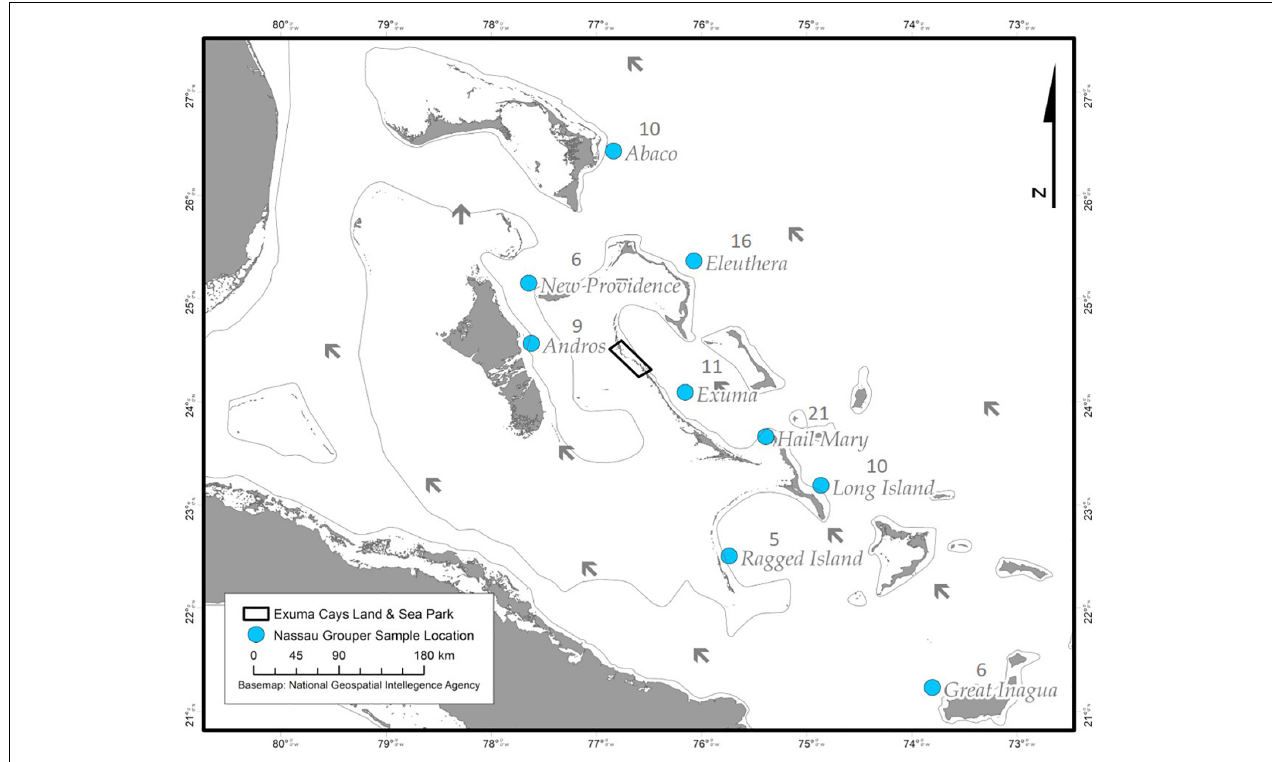
FIGURE 1 | Sampling locations of Nassau grouper (blue circles) and prevailing currents (black arrows) showing the extent of the Exuma Cays Land and Sea Park (rectangle).